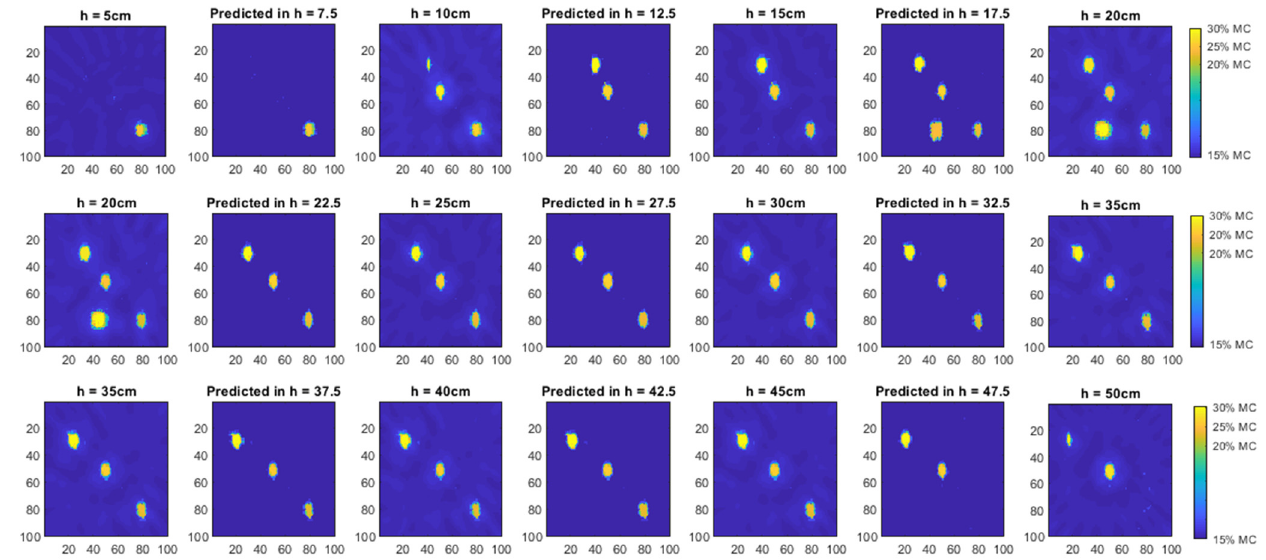
Figure 7. The locations of moisture distribution in (5 cm, 10 cm, 15 cm, 20 cm, 25 cm, 30 cm, 35 cm, 40 cm, 45 cm, and 50 cm) and predicted in high (7.5 cm, 12.5 cm, 17.5 cm, 22.5 cm, 27.5 cm, 32.5 cm, 37.5 cm, 42.5 cm and 47.5 cm).